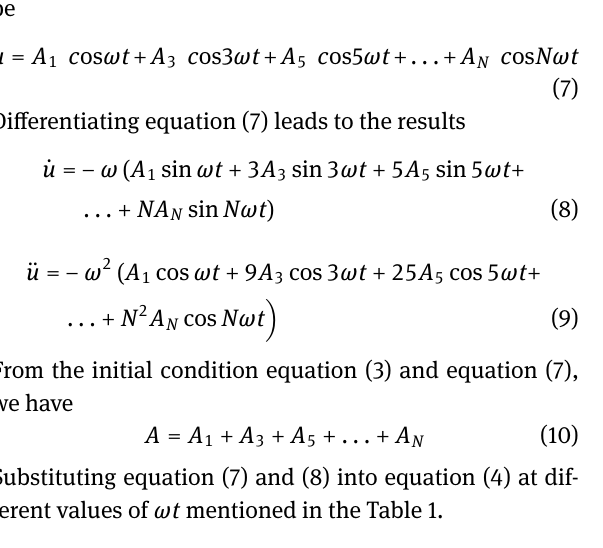
Table 1. Collocation points for different ˙ u at ωt